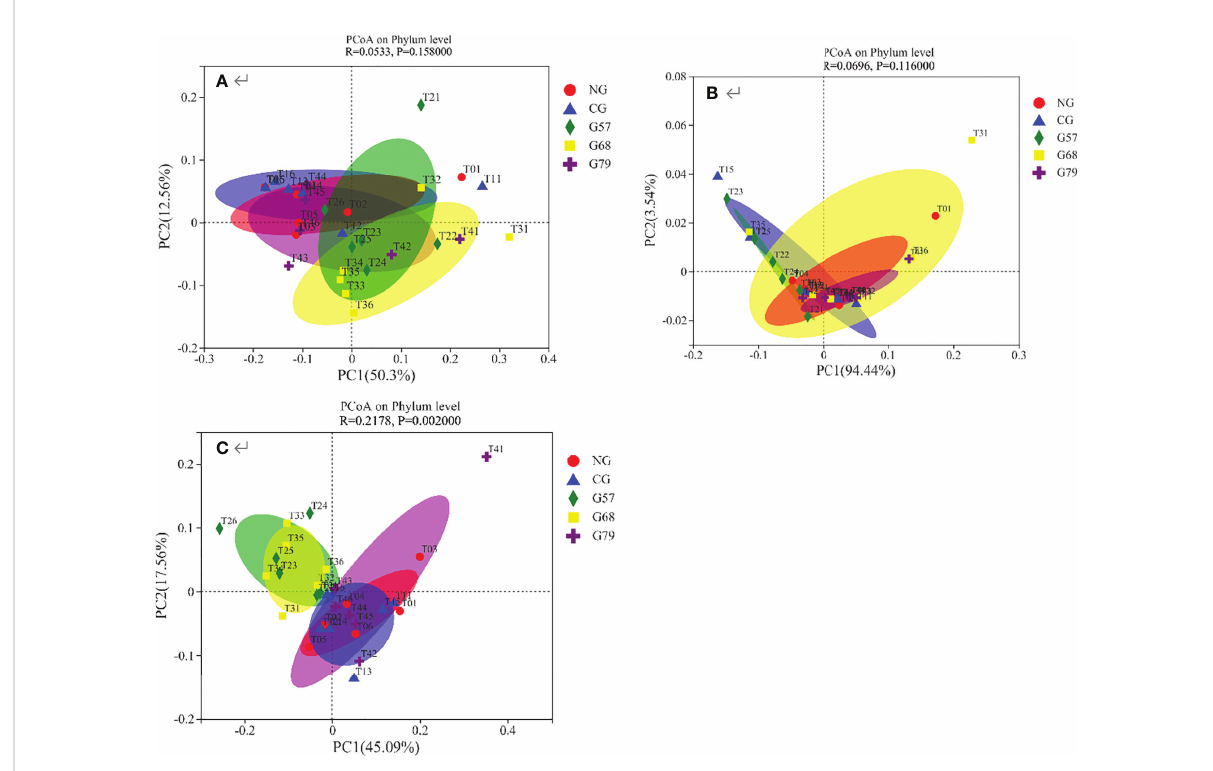
FIGURE 8 Soil microbial PCoA analysis in fi ve grassland management treatments: (A) bacteria; (B) fungi; (C) archaea; NG: No grazing; CG: Continuous grazing; G57: Grazing in May and July; G68: Grazing in June and August; G79: Grazing in July and September. The error bars in the fi gure represent the standard error, and the lowercase letters represent the signi fi cant differences ( P